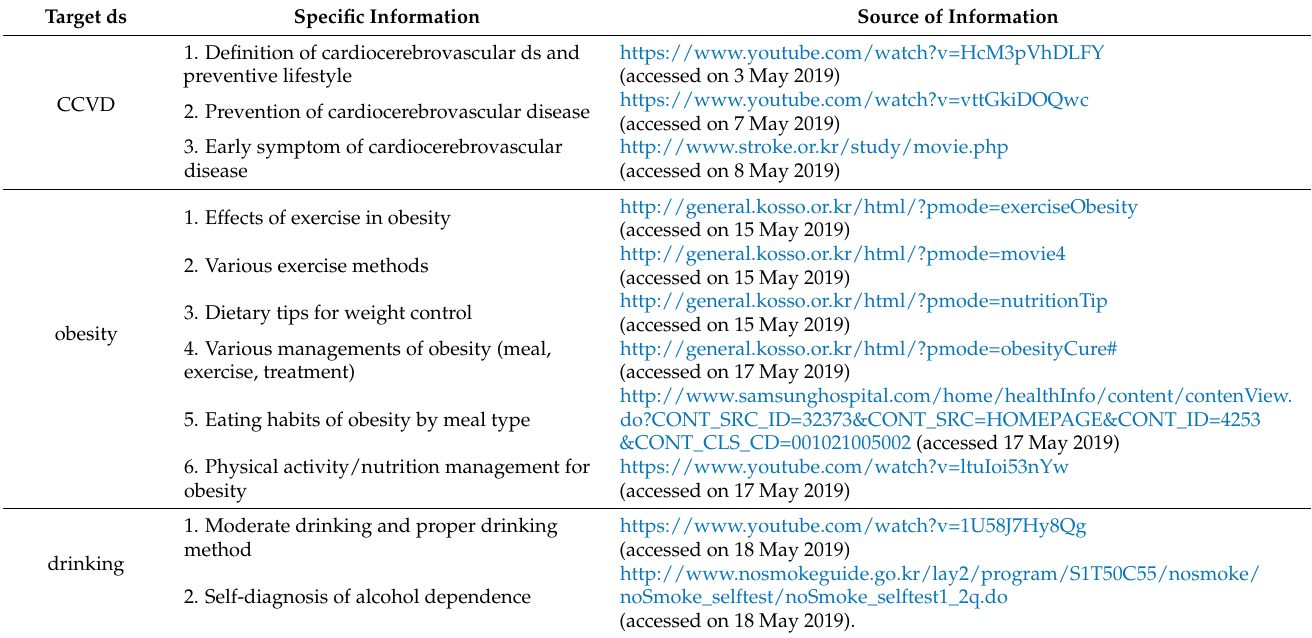
Table 1. Specific information and sources for follow-up management according to target